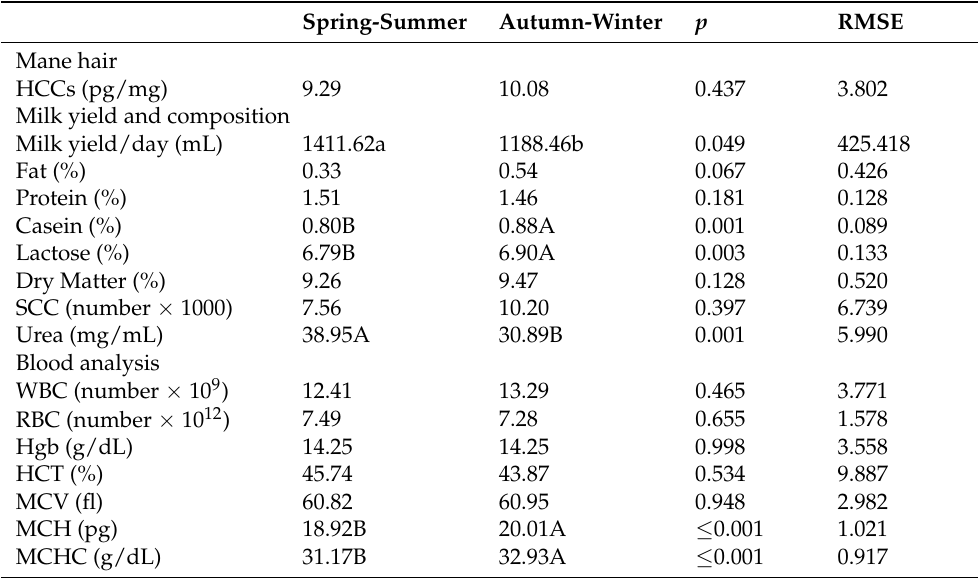
Table 3. Effects of the production season on hair cortisol, milk production and blood